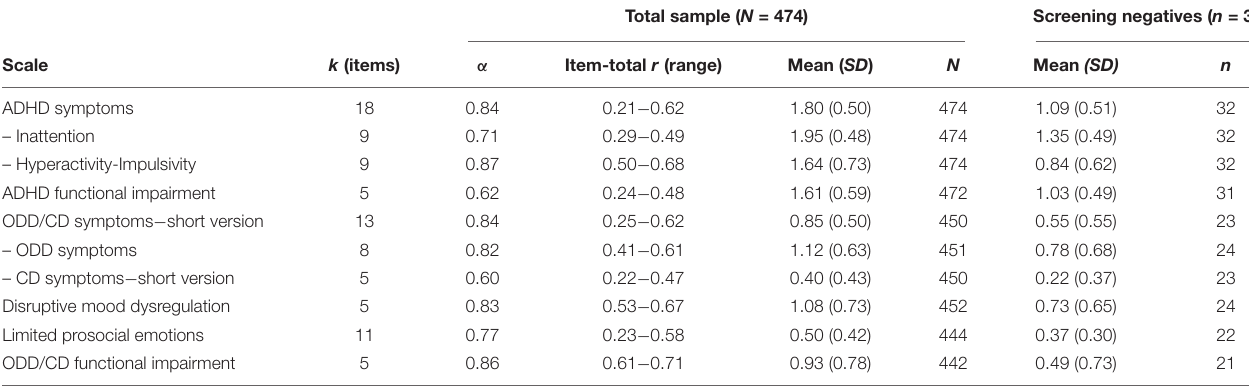
TABLE 2 | Scale characteristics, Cronbach’s alpha ( α ) and range of item-total correlations of the